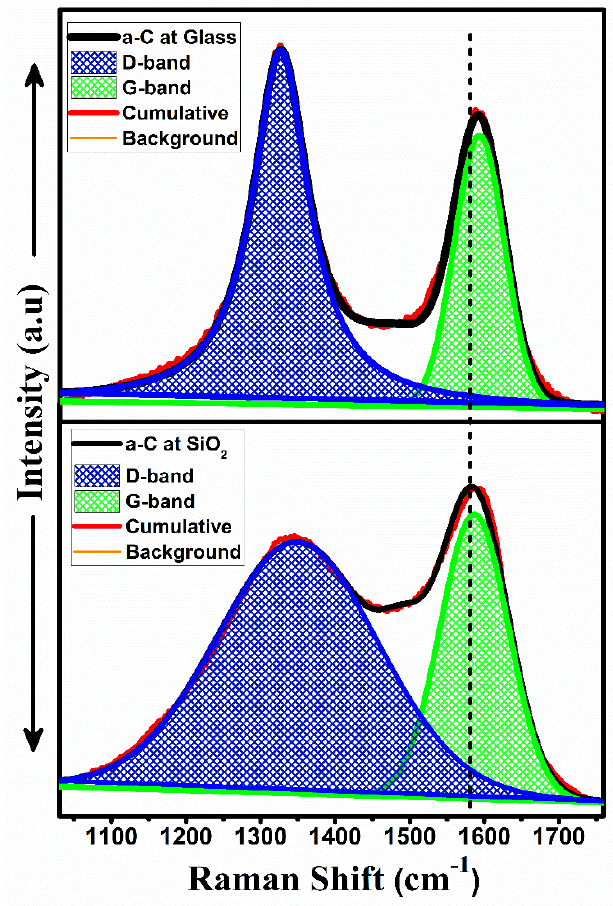
Figure 4. Raman bands of sample a-Carbon films on glass and SiO 2 substrates.